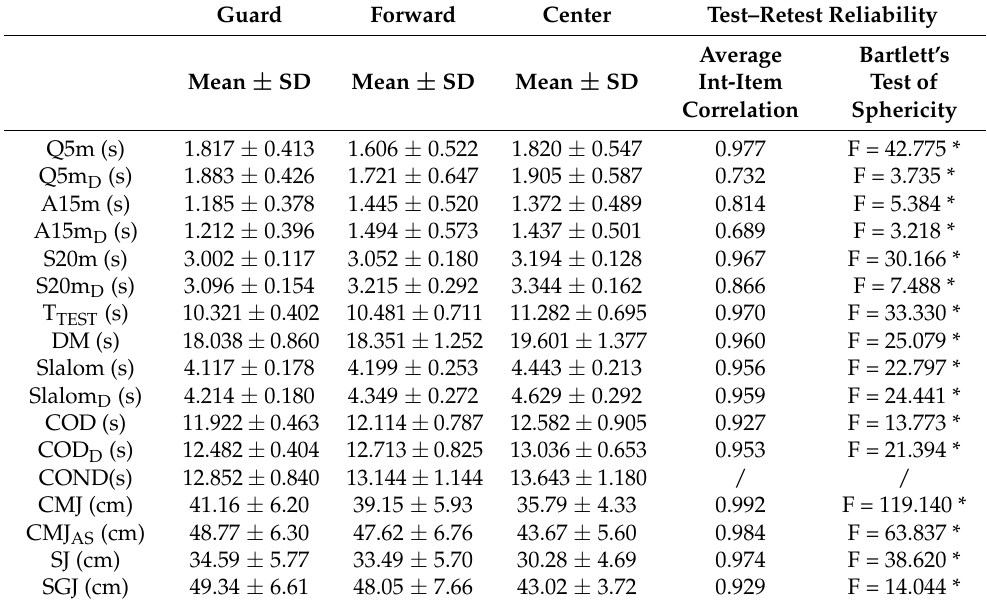
Table 1. Descriptive statistics and Intraclass correlation coefficients.